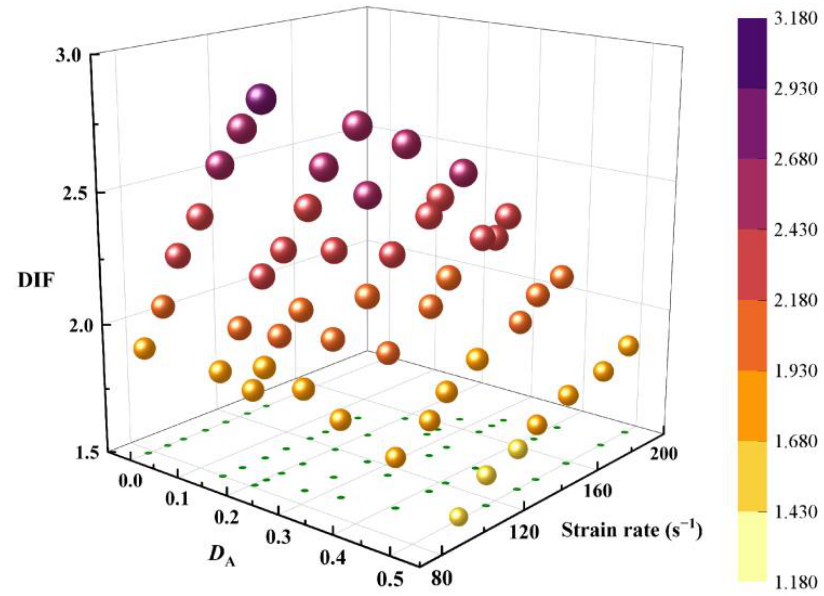
Figure 12. Variation in the DIF with the strain rate and accumulated damage variable.